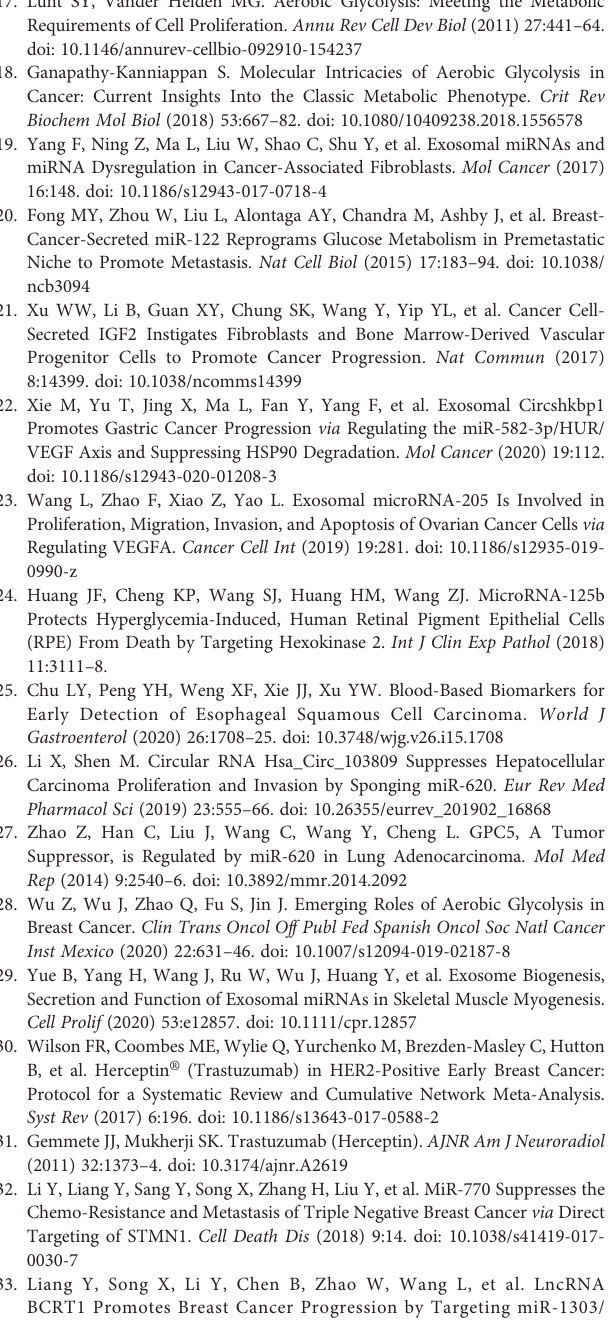
Supplementary Figure 5 | Exosomal miR-620 is highly secreted in ESCC cells. (A) The expression of miR-620 in supernatant of normal esophageal cell line Het-1A and ESCC cell lines was detected by qRT-PCR. (B) The morphology of exosomes secreted from ECA-109 and KYSE450 (exosomes labeled NC-Exo) were observed through electron microscopy. (C) PKH67 staining-laser confocal microscopy was used to observe whether exosomes could enter recipient cells. (D) RNase A, along with Triton X-100 was used to treat the culture medium of ESCC cells and the expression of miR-620 in different groups was measured. **P < 0.01. Supplementary Table 1 | Information on related